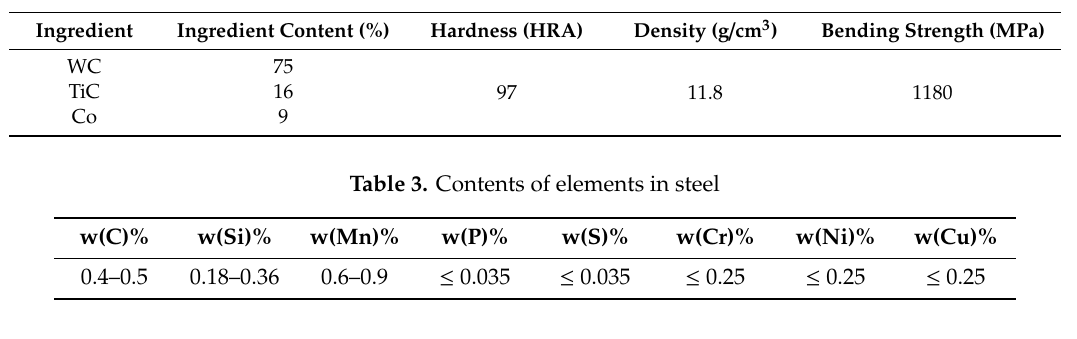
Table 2. Main components and mechanical properties of cemented carbide.